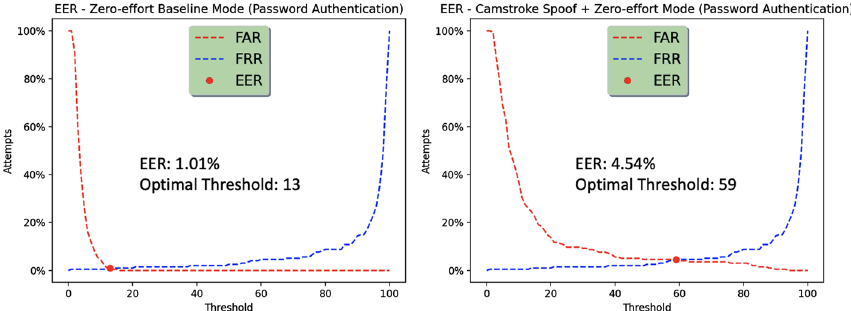
Fig. 16 EER comparison for password-mode, before attack (left) and after the attack (right)